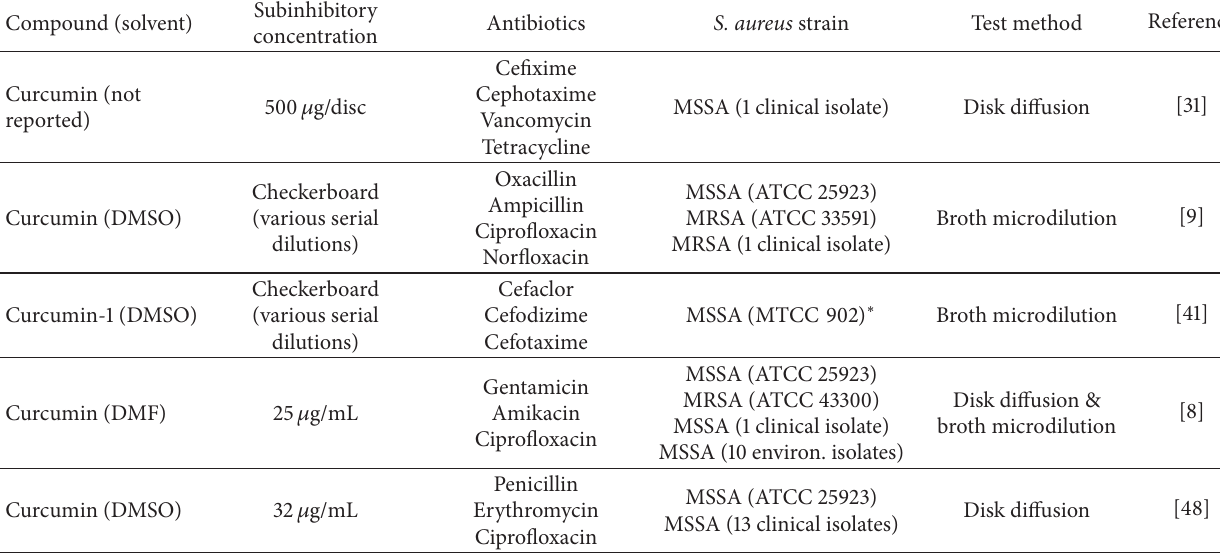
Table 2: Synergism of curcumin against S.